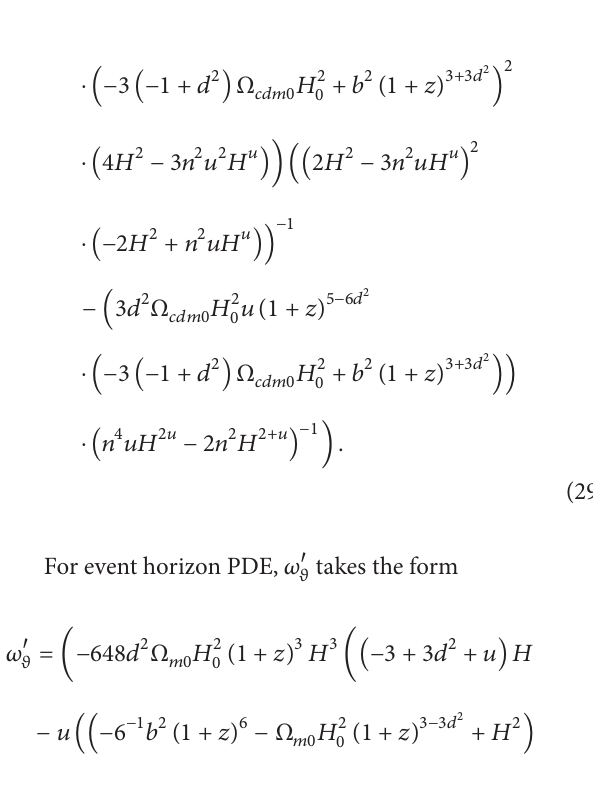
Figure 1: Plots of 𝐻 versus 1 + 𝑧 for Hubble horizon PDE model in dynamical Chern-Simons